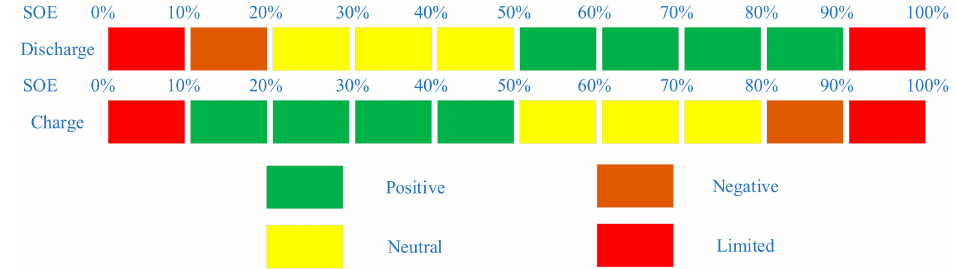
Figure 4. Strategy of charging and discharging.